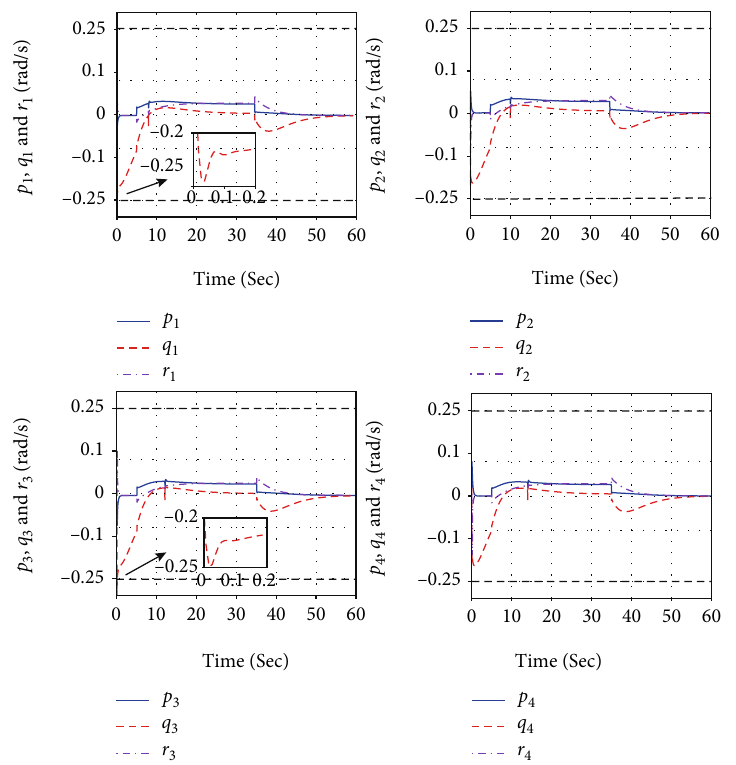
Figure 8: The time responses of p